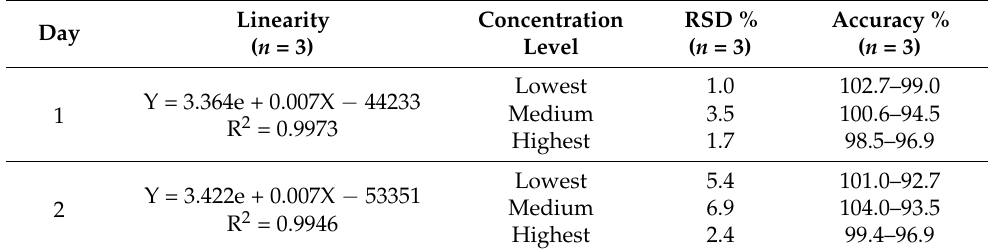
Table 3. Linearity, repeatability, intermediate precision and accuracy of the HPLC-DAD